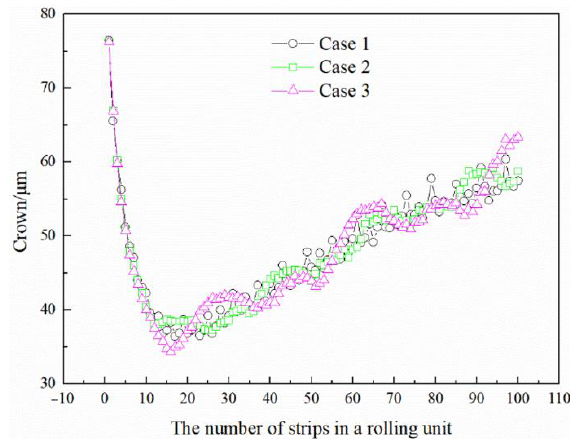
Figure 10. Strip crown fluctuation in a rolling unit with different shifting number of strips.